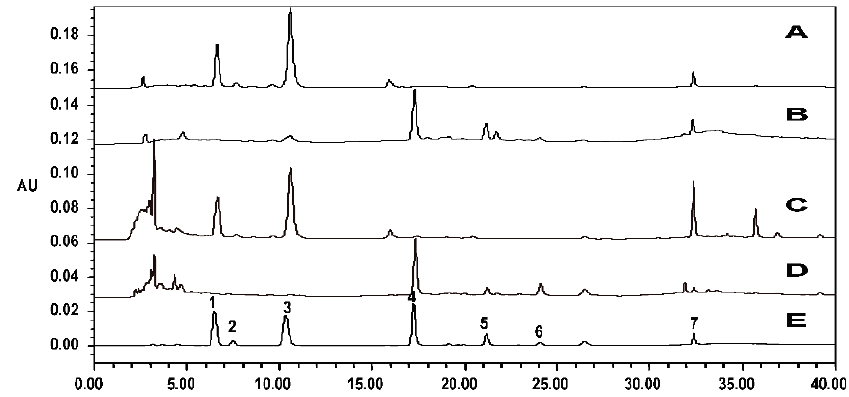
Figure 8. HPLC chromatogram of sample FPC ( A ); sample FPC-12 ( B ); sample PC ( C ); sample PCC ( D ); and the standard mixtures ( E ). Seven peaks were identified by comparing with the standard substance: myricetrin (1), isoquercitrin (2), quercitin (3), quercetin (4), huaicarbon B (5), cecarbon (6), and amentoflavone